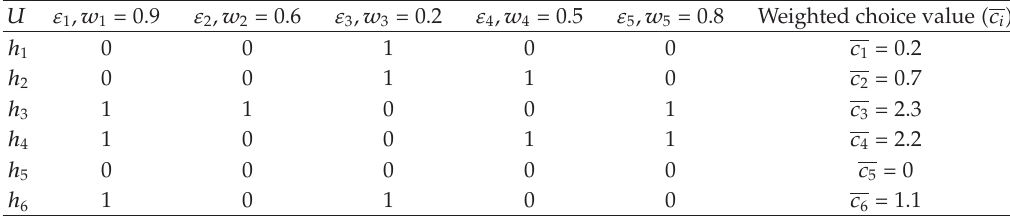
Table 10: Tabular representation of L (cid:5)(cid:5) F ,A (cid:6) ; α,λ (cid:6) with weighted choice values.